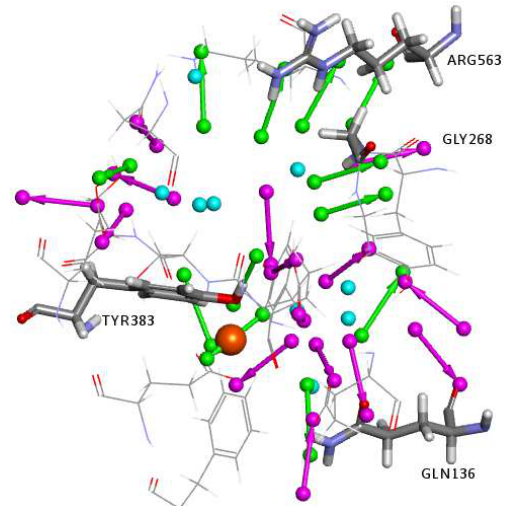
Figure 3. Clustered and edited features obtained from the interaction generation protocol. Location spheres were hidden for clarity. HBD are in magenta, HBA are in green, and the HY are in cyan. The zinc atom is shown as an orange sphere.